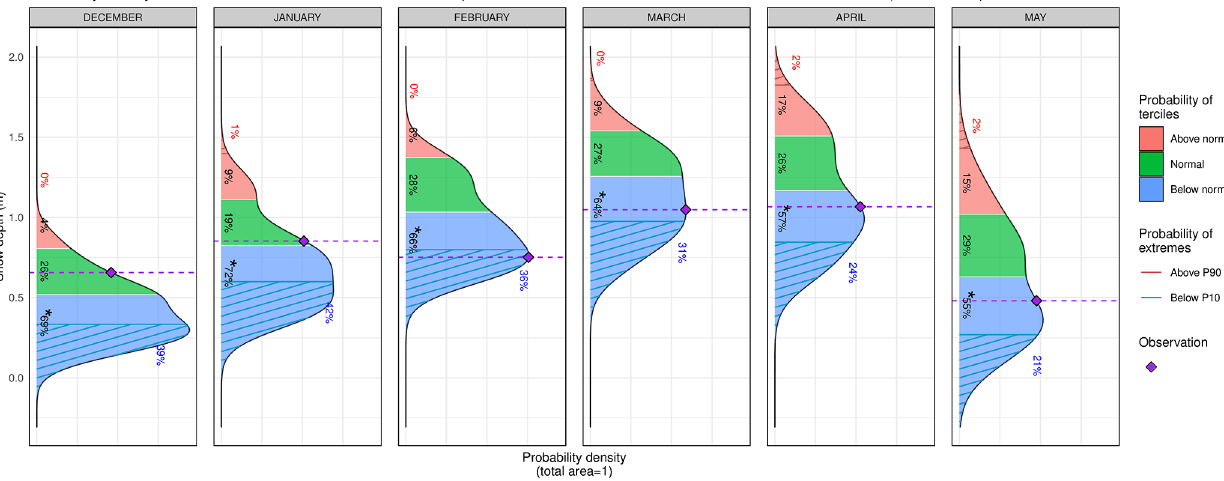
Figure 4. Probability density functions (PDFs) of the ECMWFS5-SNOWPACK monthly mean snow depth ensemble forecasts for the season 2006–2007 (starting date: 1 November 2006; lead times: 2, 3, 4, 5, 6, and 7 months) and for the station of Bocchetta delle Pisse, 2410ma.s.l. in the Italian Alps. Areas in blue, green, and coral colours represent the % probability to have monthly average snow depth below, near and above the normal conditions for the period, respectively, and the asterisk indicates the most likely tercile. Areas with blue and red parallel lines represent the probability to have monthly snow depth below the 10th percentile and above the 90th percentile, respectively. Observations are reported as purple diamonds.